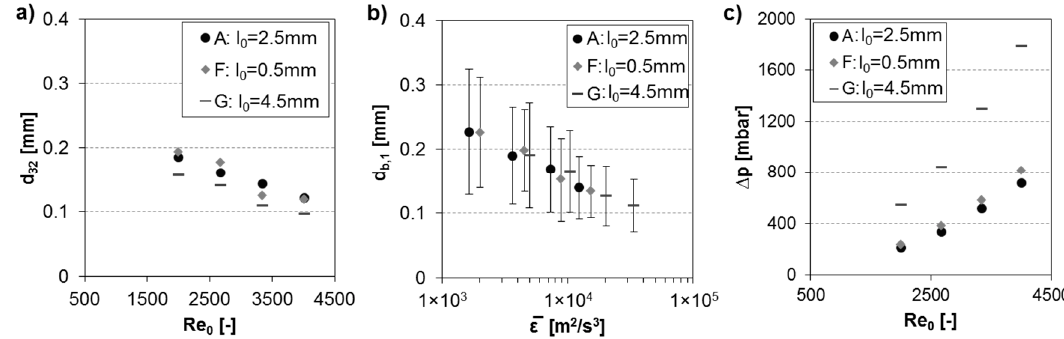
Figure 12. Influence of length of smallest cross section l 0 on size of refined bubbles behind micronozzles. Constant geometrical nozzle parameter for all displayed inlay elements: d − 1 = 1 mm, α − 1 = 8 ◦ , d 0 = 0.5 mm, α 1 = 47.5 ◦ , d 1 = 1.25 mm. Length of nozzle’s smallest cross section exhibited different values, i.e., for nozzle F: l 0 = 0.5 mm, for nozzle A: l 0 = 2.5 mm, and for nozzle G: l 0 = 4.5 mm. Volumetric flow rates of (cid:1848)(cid:4662) (cid:3047)(cid:3042)(cid:3047) = 60, 80, 100, and 120 mL/min are employed for each nozzle inlay. ( a ) Sauter bubble diameter plotted over Reynolds number in smallest cross section for varied l 0 ; ( b ) mean bubble diameter of refined dispersed phase plotted over mean energy dissipation rate for varied l 0 ; ( c ) pressure drop for tested nozzle inlays A, F, and G.